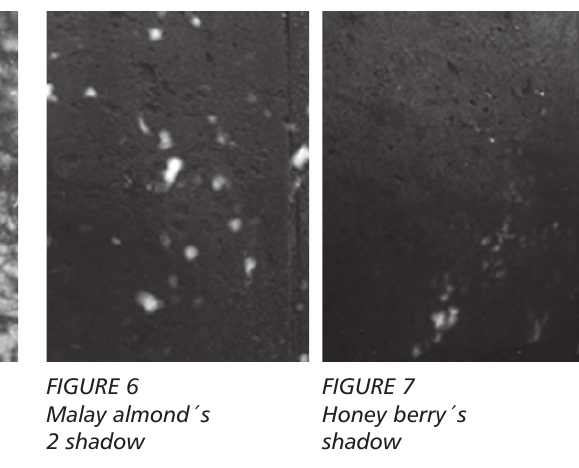
Malay almond´s Honey berry´s RESULTS AND DISCUSSION The average comfort level temperature was 30.3ºC and ranged from 30.1ºC to 34ºC. For the temperature measured at the sidewalk, the average value with shadow effect was 29.8ºC and ranged from 26.0ºC and 40.7ºC, while the average value without shadow effect was 40.8ºC and ranged from 40.3ºC to 77.2ºC.